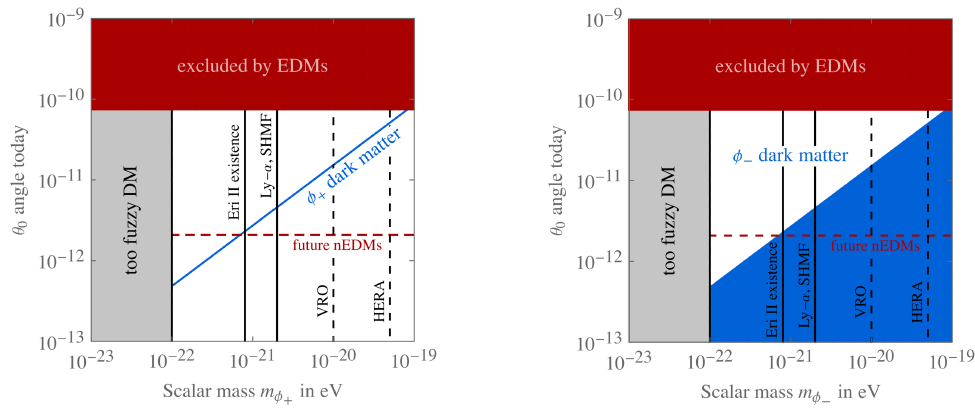
Figure 11 . Parameter space for which φ + (left panel) or φ − (right panel) constitute the totality of DM of the Universe, as function of their mass and the θ -angle today. The DM relic density is reproduced along the blue line (left panel) or white region (right panel). The red shaded region (dashed line) shows bounds [86] (future prospects [87–89]) from hadronic EDM searches. New ideas involving molecular compounds could further improve future sensitivities [90–94]. We also plot in black constraints on fuzzy DM from Lyman- α forest [95–100], measurements of the subhalo mass function [101] and the Eridanus II dwarf galaxy [102] (similar to the constraints from other dwarf galaxies [103, 104]). We shade the area where multiple observations disfavor the corresponding DM mass hypotheses [58]. The dashed lines denotes the potential sensitivity from future observations in 21 cm cosmology (HERA) [105] and by the Vera Rubin Observatory